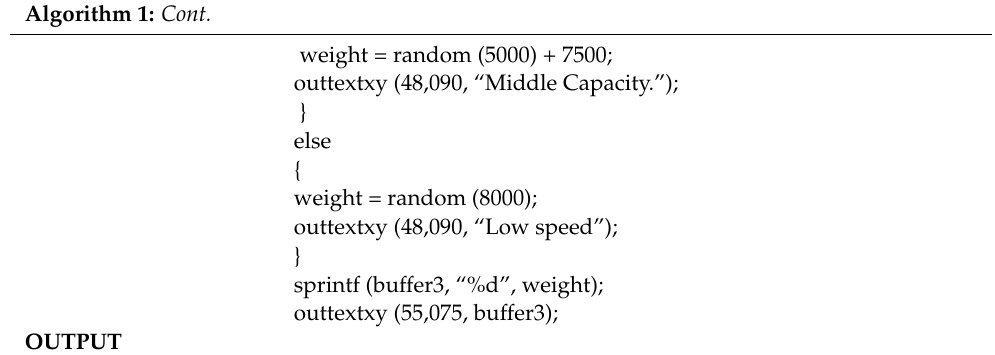
Figure 4. The degree of moisture on the road.